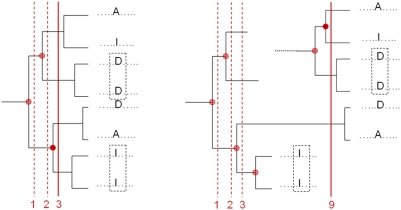
Examples of tree trace levels.Left: residues I and D at position  in the alignment are conserved in two subtrees (dotted
box), and this sets  as a tree trace of level 3. Right: residue I and D are
conserved in two subtrees detectable at levels 3 and 9 respectively, and
this sets  as a tree trace of level 9.